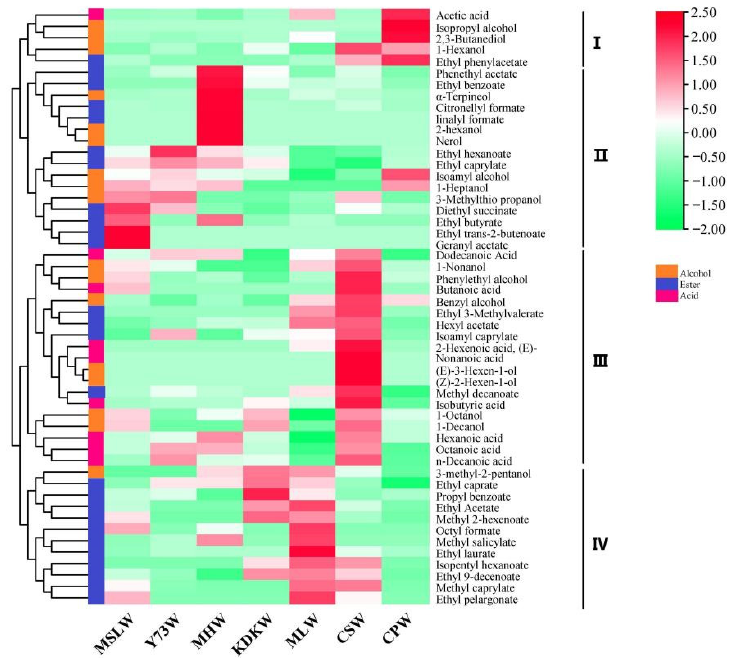
Figure 9. Heatmap analysis of alcohol, ester, and acid compounds in wines produced from seven different grape varieties. The boxes of three colors on the left side represent different compounds categories. Here, I, II, III, IV represent these compounds as clustered into four groups. Samples’ full names, as follows: MSL (Marselan), Y73 (Yan 73), MH (Muscat Hamburg), KDK (Kadarka), ML (Merlot), CS (Cabernet Sauvignon) and CP (Crimpose). Furthermore, G represents “grape” and W represents “wine”.